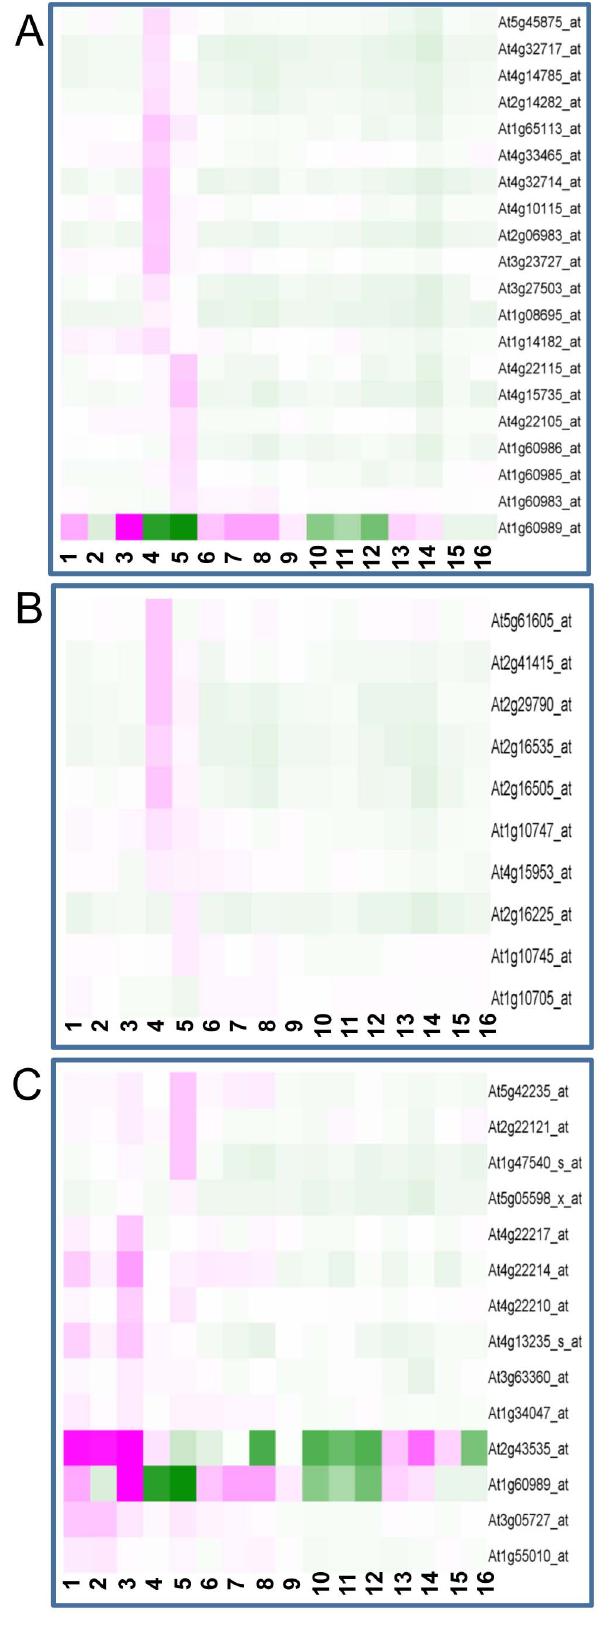
Figure 5. Gene expression profiles of Arabidopsis. A, SCR s. B, MEG s. C, Seeding- and root-specific/enhanced DEFL s. Treatments and